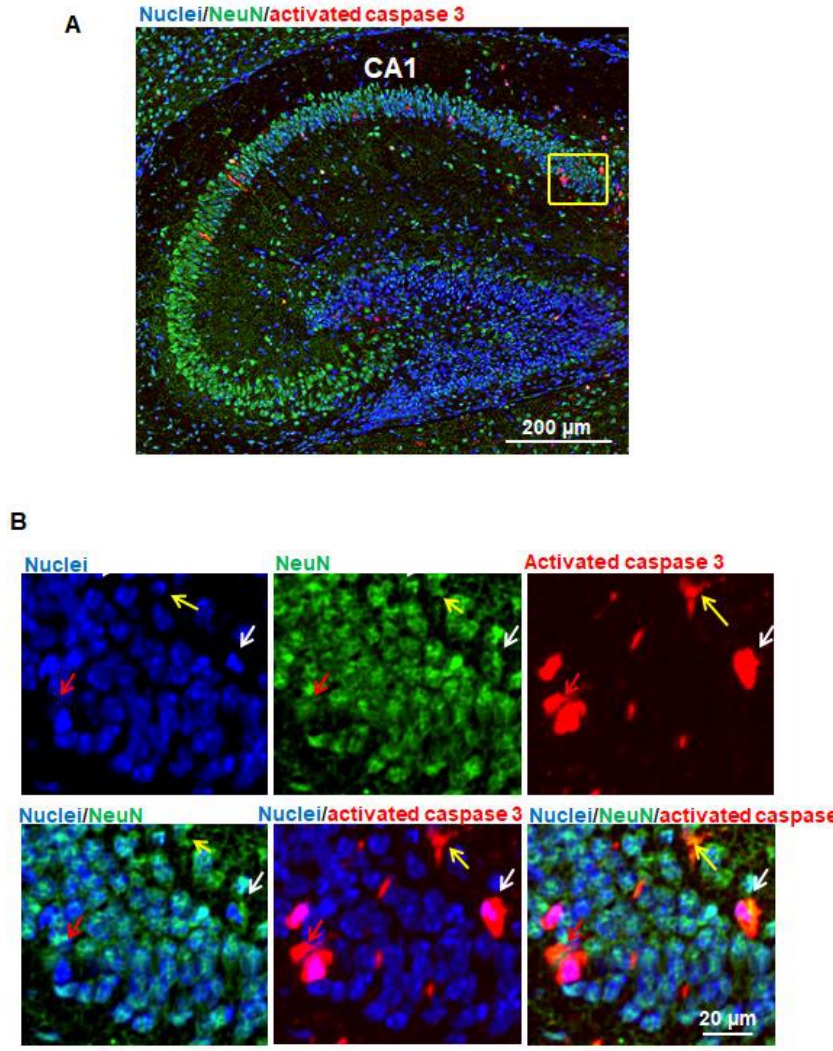
Figure 3. Propofol induces apoptosis in neurons in the hippocampus. ( A ) Fluorescence images of the hippocampus treated with propofol. In order to identify whether neurons in hippocampus undergo apoptosis following propofol exposure, the brain sagittal section were co-stained with activated caspase 3 and neuronal nuclear antigen (NeuN; neuron marker). Cell nuclei were stained with Hoechst 33342. Blue, green, and red represent cell nuclei, NeuN, and activated caspase 3 signals. Scale bar = 200 µ m; ( B ) The magnified view of the yellow-boxed region shown in Figure 3A. These images include the individual channel and overlaid images and show that some activated caspase 3 and NeuN signals were co-localized in the same cells, suggesting that propofol induces apoptotic neuron death. Three representative apoptotic neurons are indicated by yellow, white, and red arrows. Scale bar = 20 µ